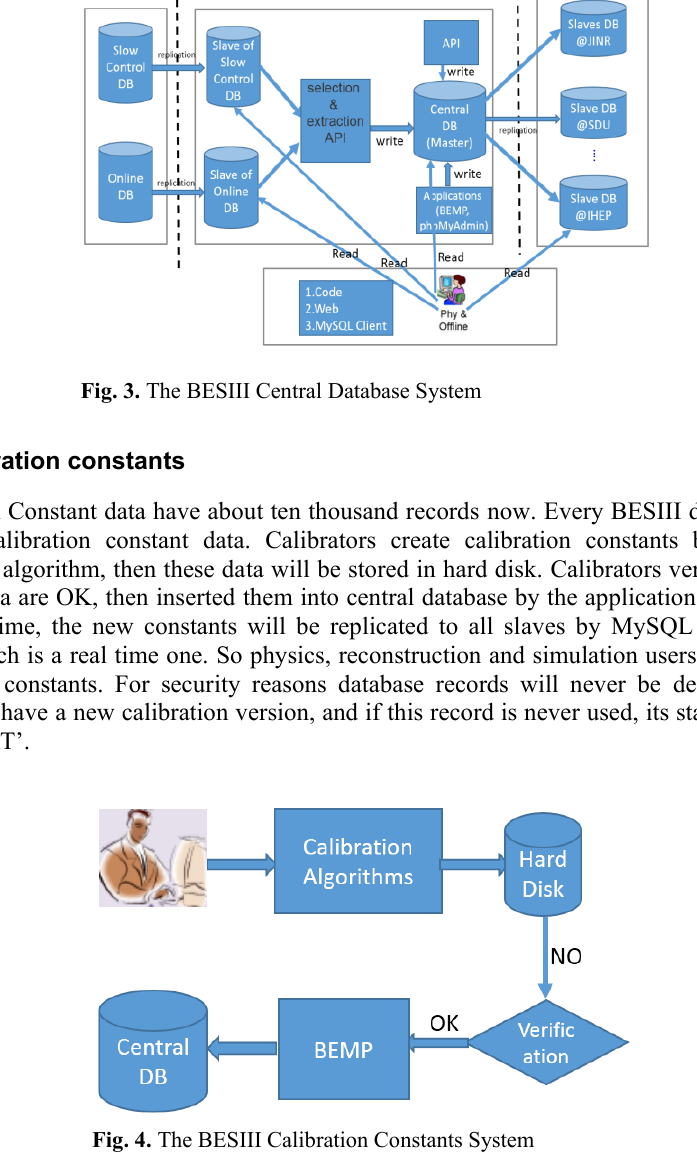
Fig. 4. The BESIII Calibration Constants